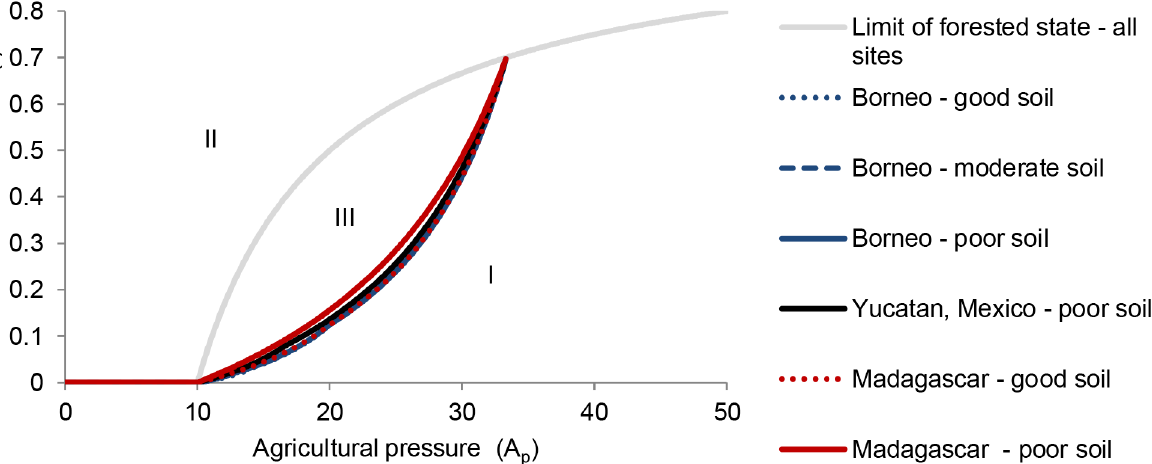
Fig 2. Stable states of the modeled shifting cultivation system. The stable states are shown here as a function of agricultural pressure and local forest recruitment rate. Region I has little forest cover (deforested stable state) while region II has extensive forest cover (forested stable state). In region III either the forested or deforested state is possible, depending on the previous forest and soil condition. The existence of two alternative stable states in this part of the model ’ s parameter space results in a hysteresis such that the current state of the system has two possible configurations depending on its previous state